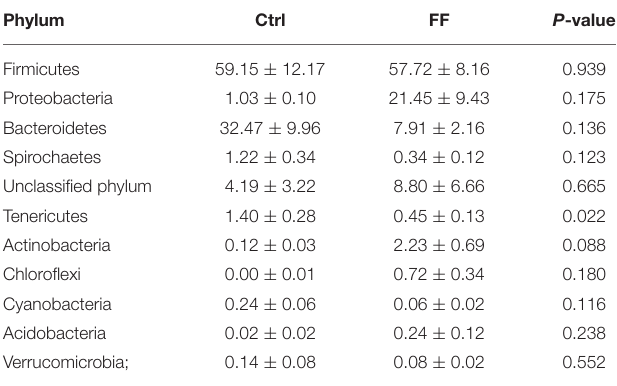
TABLE 2 | Relative abundance of microbial phylum (percentage) in the duodenal mucosa-associated microbiota of pigs in the FF and control groups.